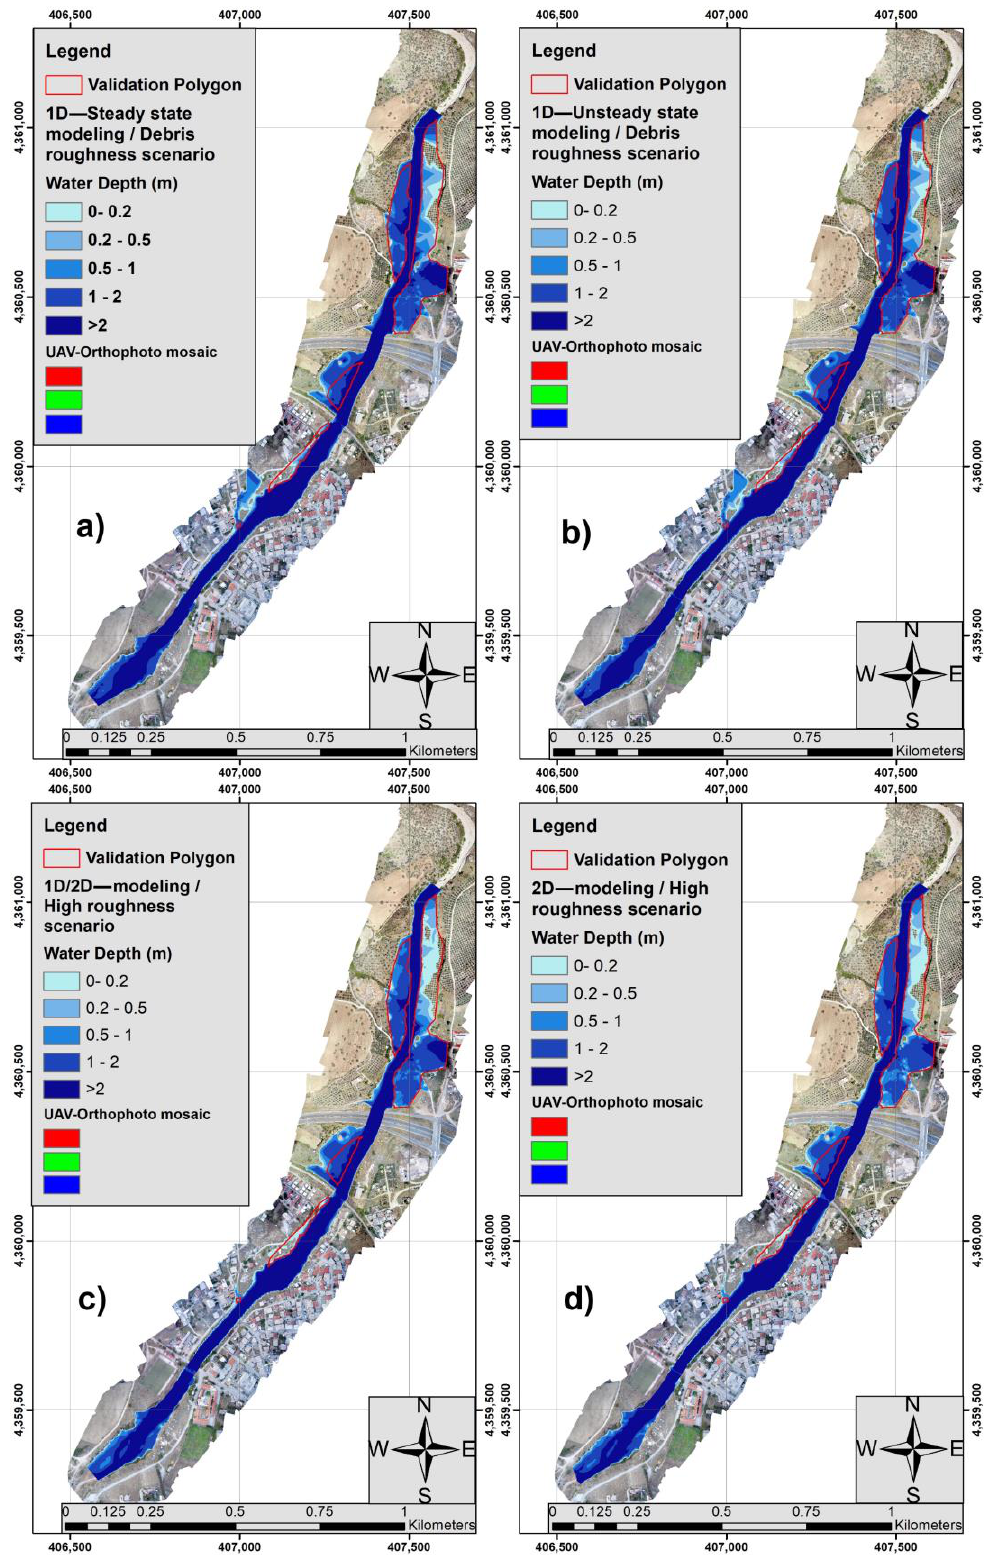
Figure 11. Optimum solutions of simulated maximum water depth and flood extent based on F1 scores: ( a ) 1D — steady-state modeling approach using debris roughness scenario; ( b ) 1D — unsteady state modeling approach using debris roughness scenario; ( c ) Coupled (1D/2D) modeling approach using high roughness scenario; ( d ) 2D — modeling approach using high roughness scenario.